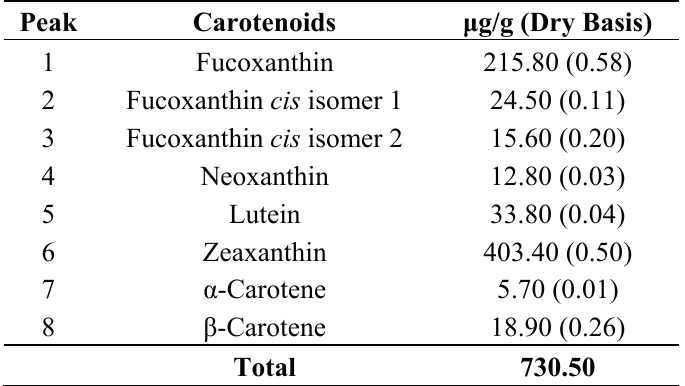
Table 2. Carotenoids composition of the methanol extract from the digestive gland of A. depilans a